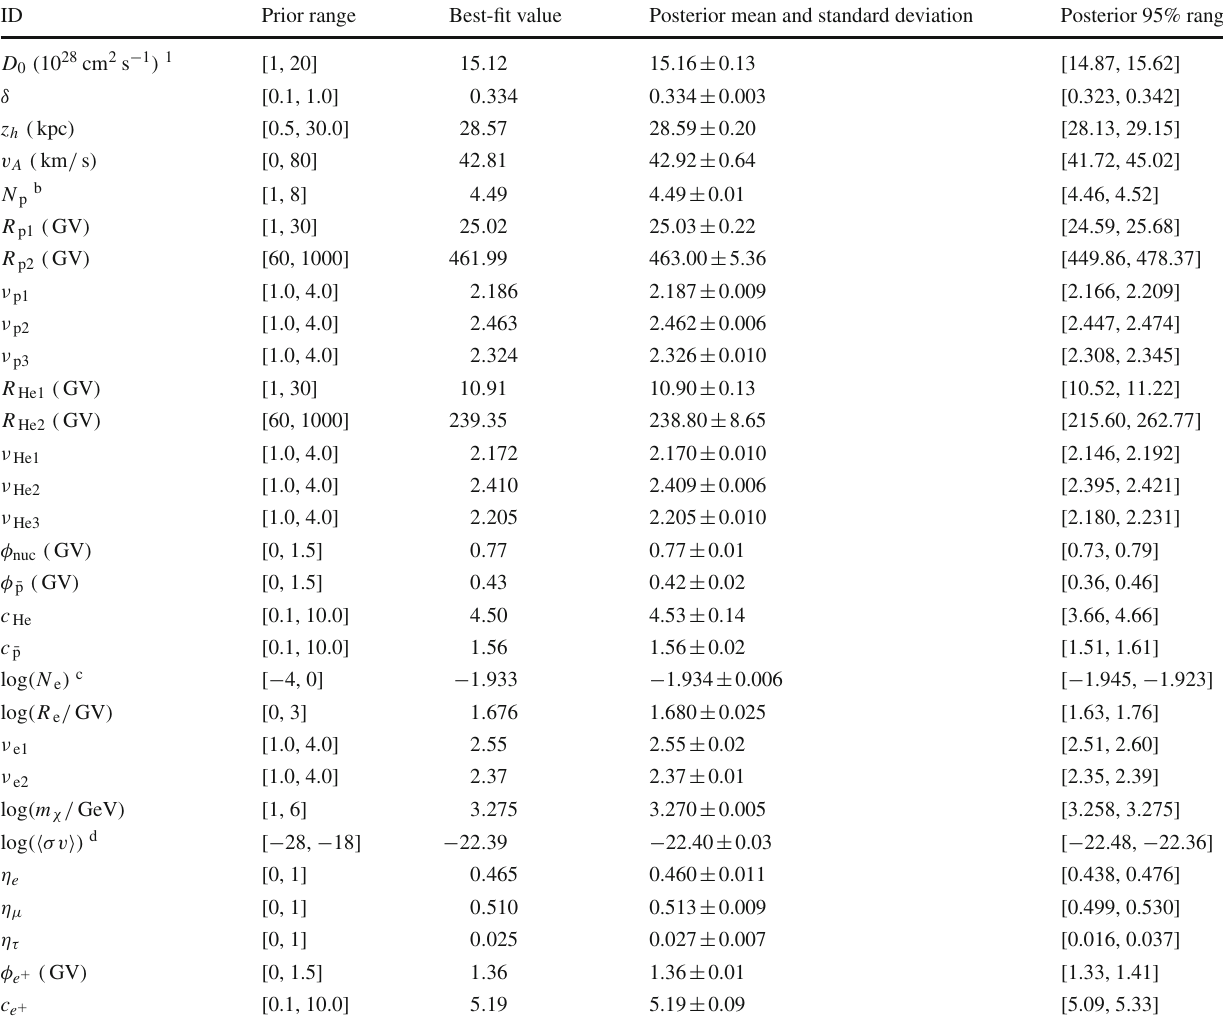
Table 4 Constraints on the parameters of DAMPE CRE spectrum, DM scenario. The prior interval, best-fit value, statistic mean, standard deviation and the allowed range at 95% CL are listed for the parameters. For the best-fit values, we have χ 2 / d . o . f . = 262 . 94 / 297 ID Prior